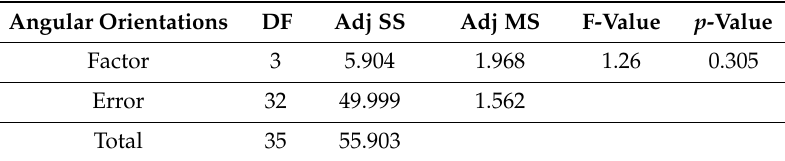
Table 15. ANOVA results for UTS as a function of angular orientations.